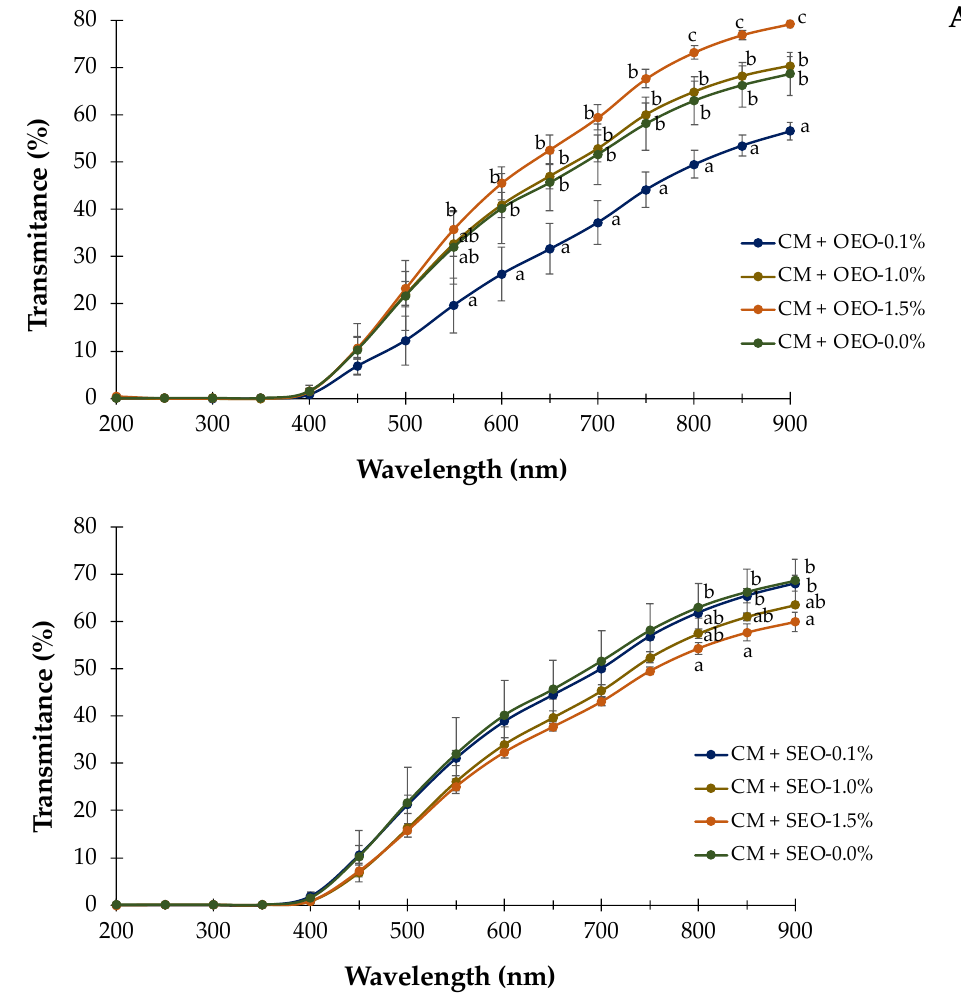
Figure 1. Effect of oregano (OEO; ( A )) or savory (SEO; ( B )) essential oil in the light transmittance (%) of chia mucilage films (CM, Muñoz-Tebar et al. [12]). a–c Different letter means significant differences ( p < 0.05) due to EO concentration. Data without any superscripts mean that there were no significant differences ( p > 0.05) either by the EO concentration effect (indicated with lower case letters) or by the EOs used in the formulation (indicated with capital letters).